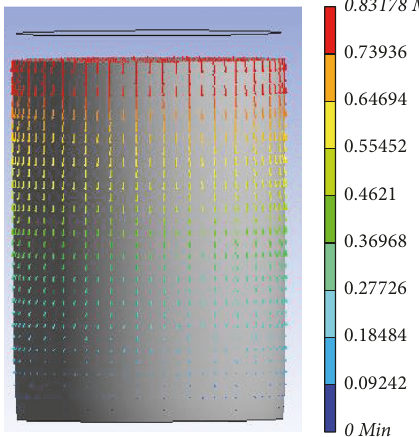
Figure 19: Linear deformation obtained.